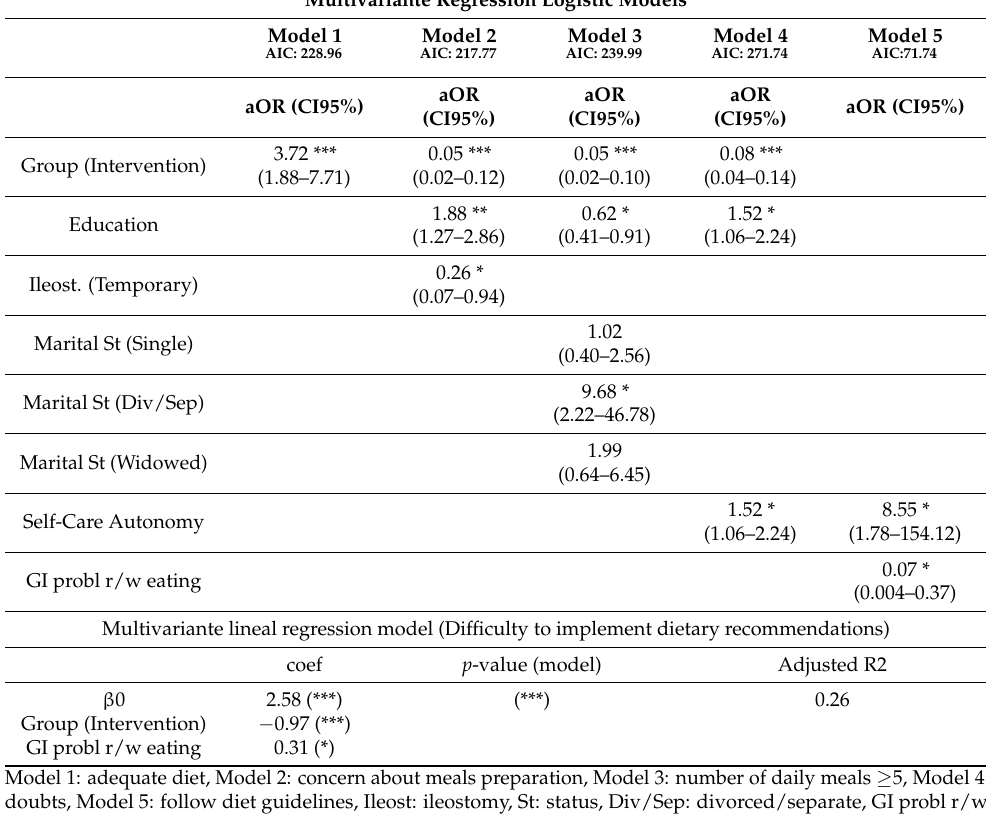
Table 3. Multivariate models for outcomes. Multivariante Regression Logistic